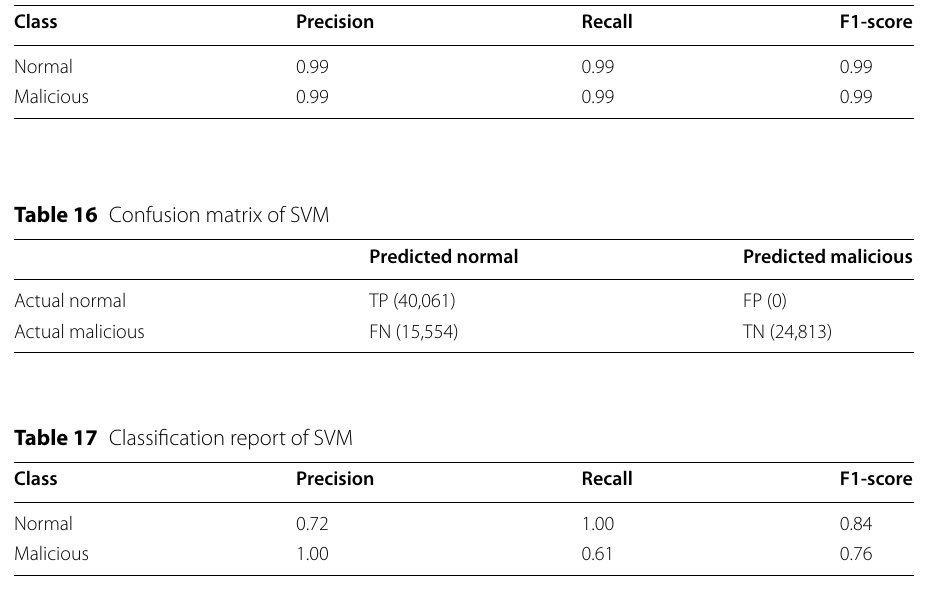
Table 15 Classification report of KNN